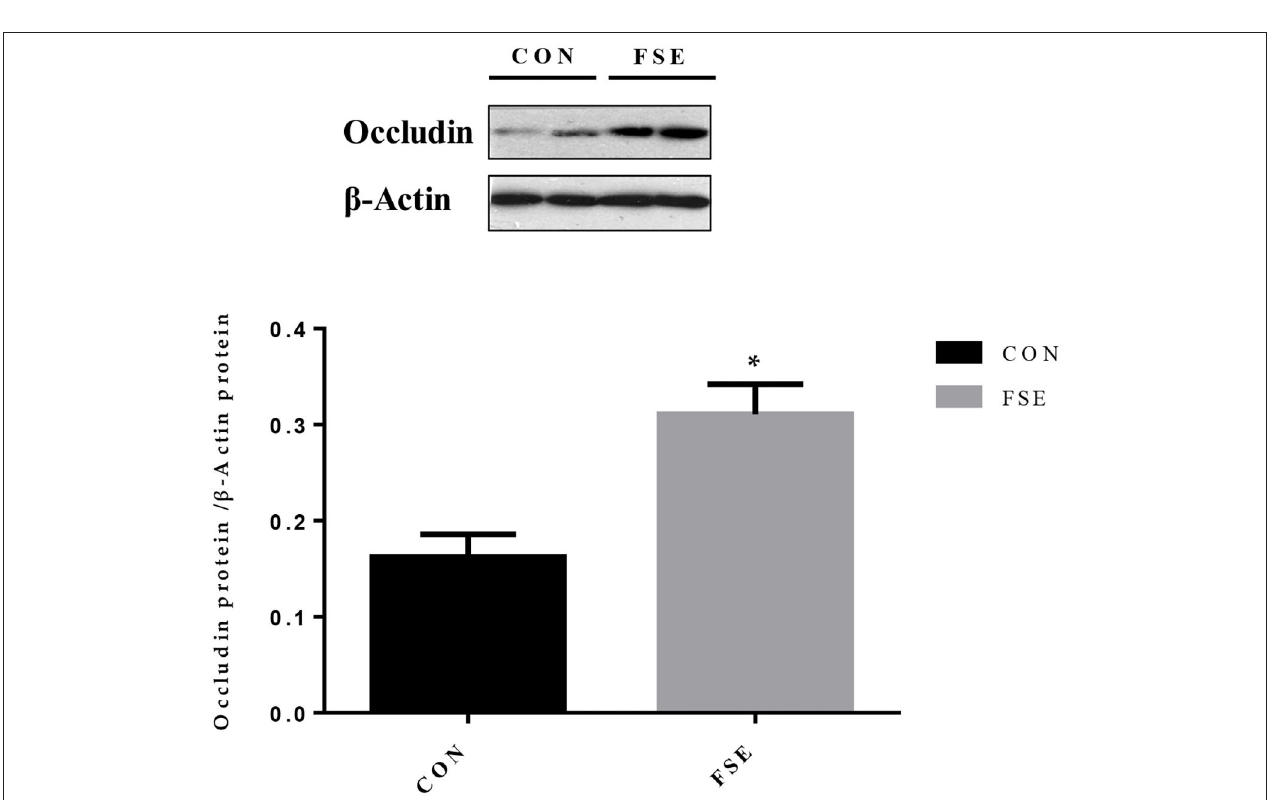
FIGURE 7 | Effects of maternal dietary Forsythia suspensa extract supplementation on protein expression of occludin proteins in jejunum mucosa of suckling piglets. CON group, basal diet; FSE group, basal diet + 100 mg/kg Forsythia suspensa extract. All values are expressed as means ± SEM. * P < 0.05. n =